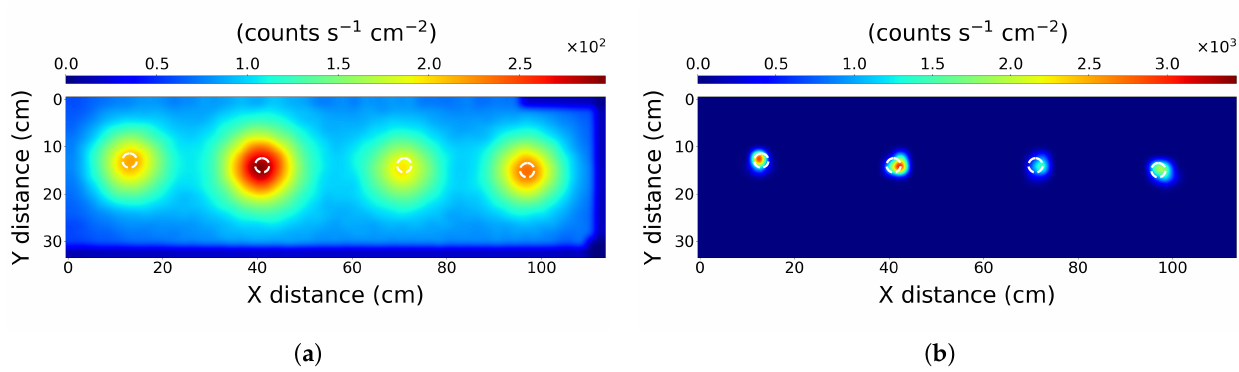
Figure 4. The results from scenario 2—Four lower activity sources. After processing with ( a ) simple interpolation, and ( b ) the PLR algorithm. The scan used a 2 cm resolution. The dashed white circles represent the true location of the source